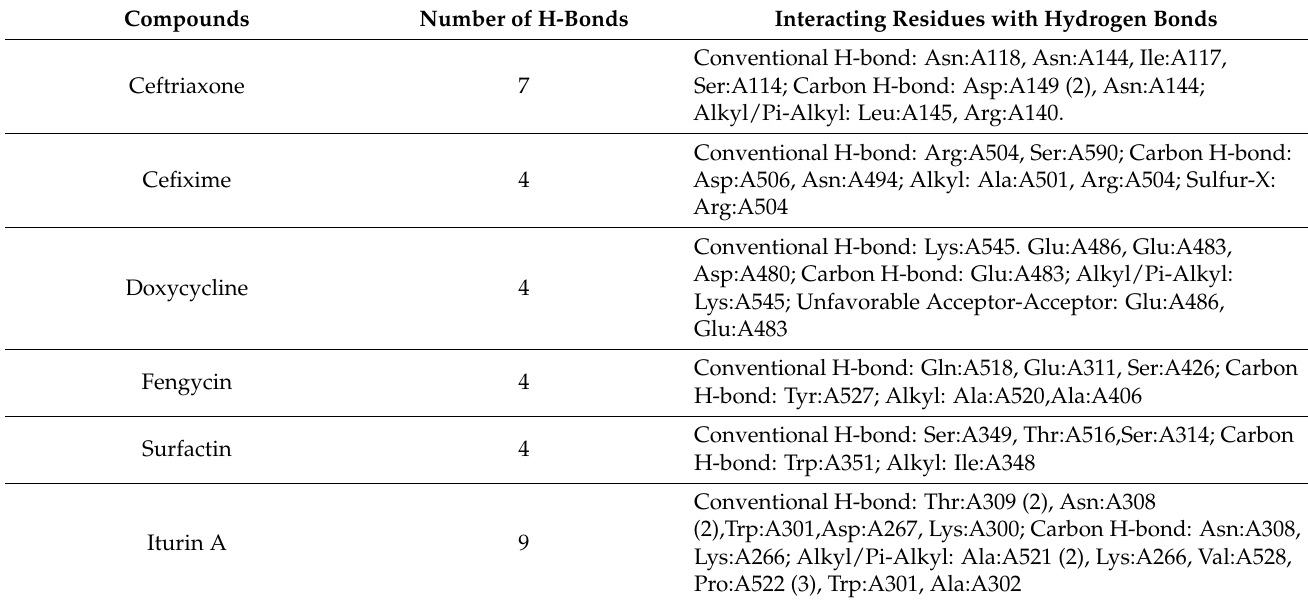
Table 4. Analysis of the compounds’ interactions with receptor PBP